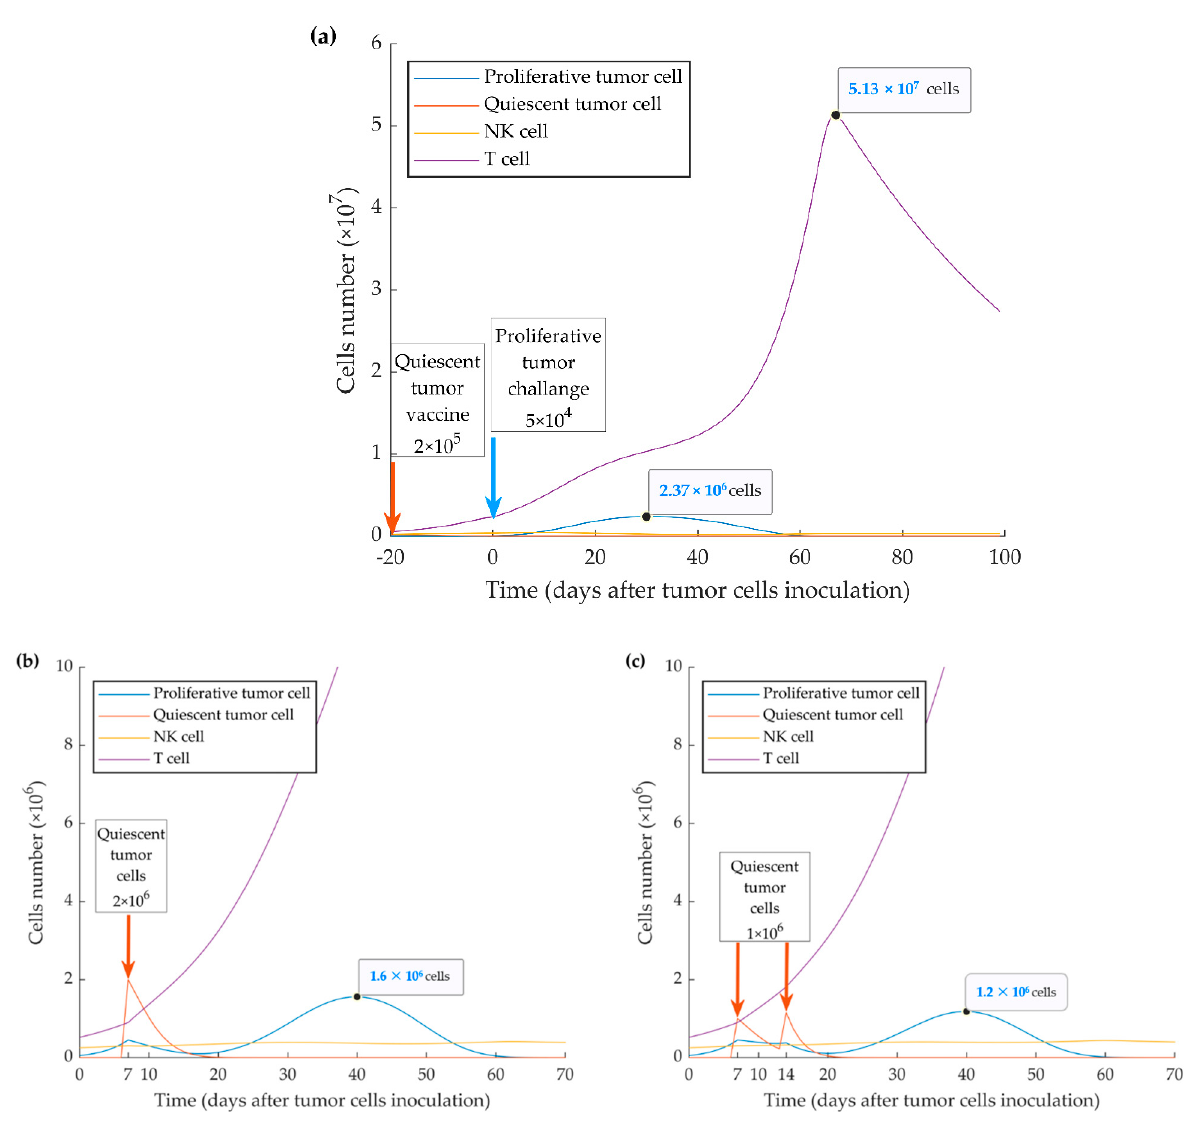
Figure 7. Mathematical simulation of a vaccination protocol. By injecting simulation of higher numbers (i.e., >2 × 10 5 cells) of quiescent cells ( a ) 20 days before implantation of wild type (WT) tumor cells, tumor growth can be suppressed. Inoculation of one-time 2 × 10 6 quiescent tumor cells 7 days after implantation of WT tumor cells ( b ) or twice 1 × 10 6 quiescent tumor cells 7 and 14 days after implantation of WT tumor cells ( c ) resulted in further or complete suppression of tumor growth, respectively.